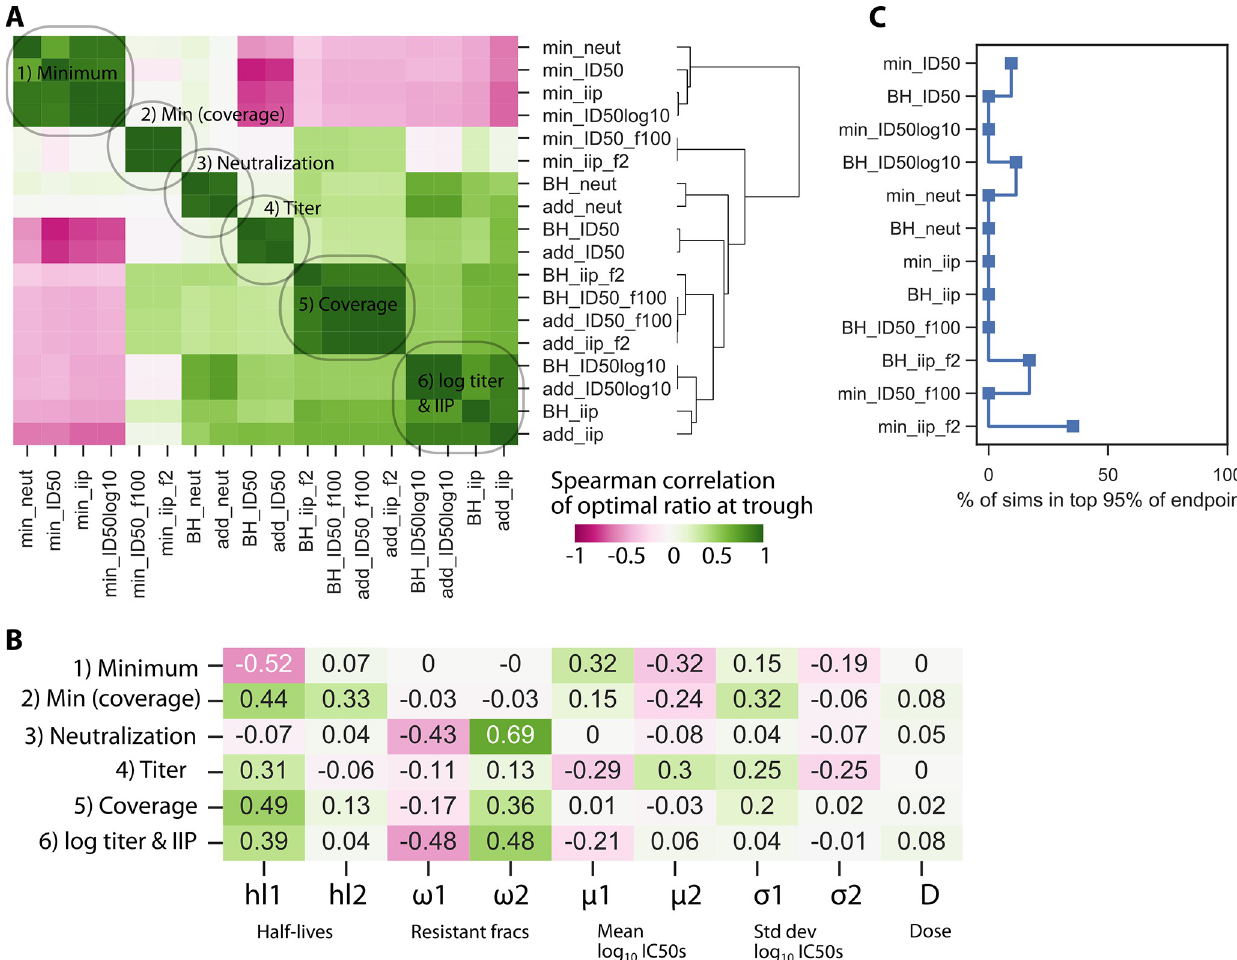
Fig 3. Sensitivity of the optimal ratio to PKPD outcome choices and antibody features. The optimal ratio was calculated for each parameter set and each outcome. A) Optimal ratios cluster by outcome similarly to the general analysis in Fig 2 with differences being that coverage and IIP can be grouped together whilst the minimum interaction model separates into 2 categories. B) Different variables drive optimization of different outcomes. Among viral pharmacodynamic inputs, the geometric mean IC50 is most influential on titer and minimum potency outcomes, while the fraction resistant is most influential for the remaining outcomes. C) A low percentage of parameter sets admitted outcomes within 95% of the optimal value.